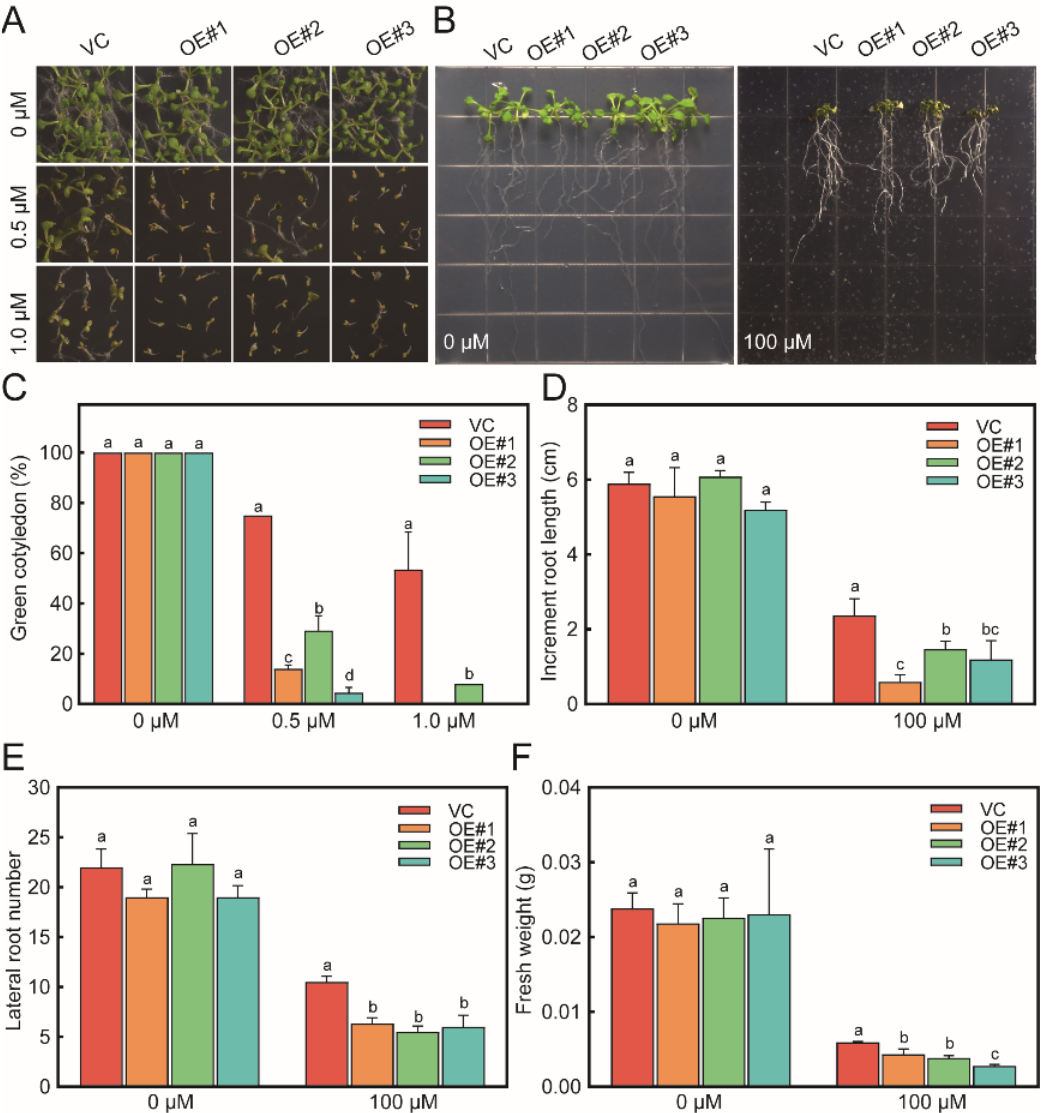
Figure 3. Enhanced ABA sensitivity in RcTINY2 -OE Arabidopsis. ( A ) Differential seed germination responses between RcTINY2 -OE and VC plants grown on ABA-treated (0, 0.5 or 1.0 µ M) MS agar plates. All photographs were taken ten days after transplantation onto plates; ( B ) Phenotypic differences in root growth between RcTINY2 -OE and VC plants under ABA treatment. Ten-day-old VC and RcTINY2 -OE plants were transformed to ABA-treated (0 or 100 µ M) MS media and grown vertically for ten days and photographed; ( C ) Green cotyledon rates between RcTINY2 -OE and VC seeds in response to ABA seven days after treatment; ( D ) Increased root length, ( E ) Lateral root number, and ( F ) Fresh weights of ten-day-old RcTINY2 -OE and VC plants subjected to ABA treatment (0 or 100 µ M). All data are the mean ± SD for three biological replicates ( n = 5). LSD tests were used to determine statistically significant differences ( p < 0.05) which are indicated by different